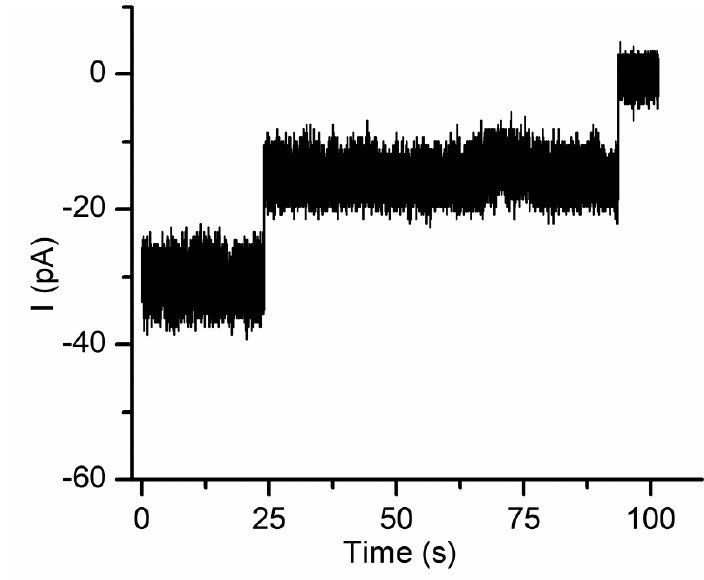
Figure 10. Cationic polymers inhibit the ionic currents in a stepwise manner. PEI addition (10 µM final concentration) rapidly closes the two lysenin channels inserted into the bilayer lipid membrane.